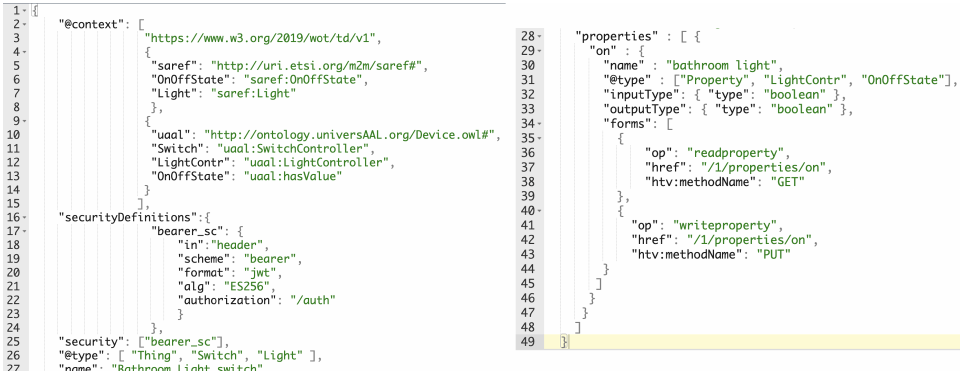
Figure 8. Thing description including SAREF and uAAL